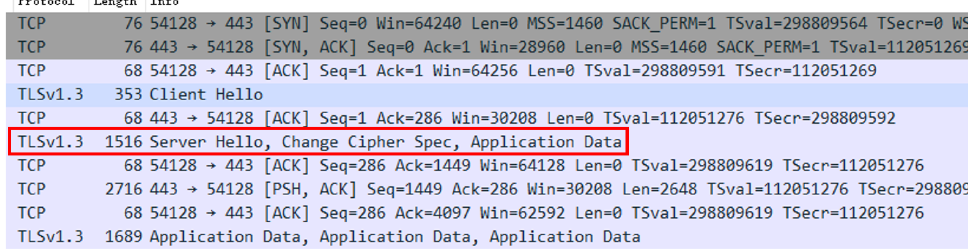
Figure 13. TLS handshake and encrypted messages